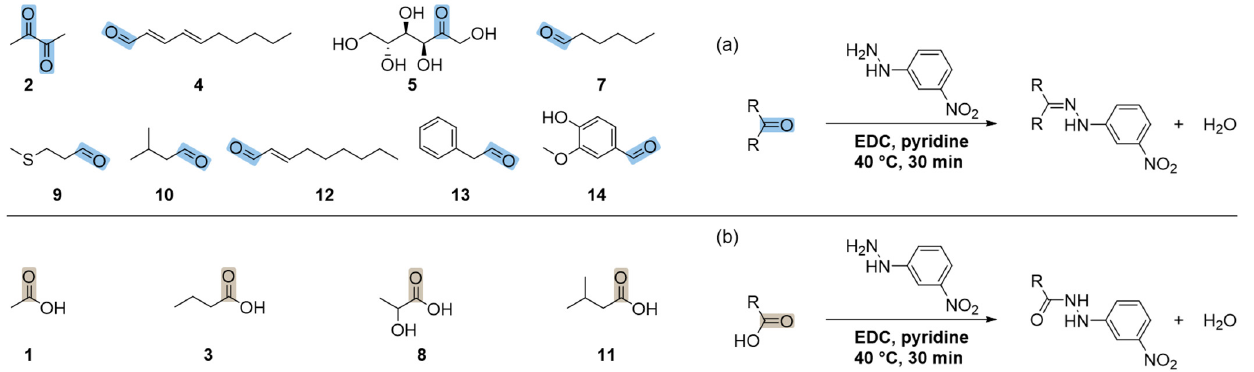
Figure 3. The derivatization of aldehydes, ketones ( a ), and organic acids ( b ) with 3-nitrophenylhydrazine (3-NPH) using N -(3-(dimethylamino)propyl)- N ′ -ethylcarbodiimide (EDC) as a coupling reagent and pyridine as a catalyst: 2,3-butanedione ( 2 ), ( E,E )-2,4-decadienal ( 4 ), D-fructose ( 5 ), hexanal ( 7 ), methional ( 9 ), 3-methylbutanal ( 10 ), ( E )-2-nonenal ( 12 ), phenylacetaldehyde ( 13 ), vanillin ( 14 ), acetic acid ( 1 ), butyric acid ( 3 ), lactic acid ( 8 ), and 3-methylbutyric acid ( 11 ). The carbonyl groups of aldehydes as well as ketones are colored blue and the carbonyl groups of organic acids are colored light brown.